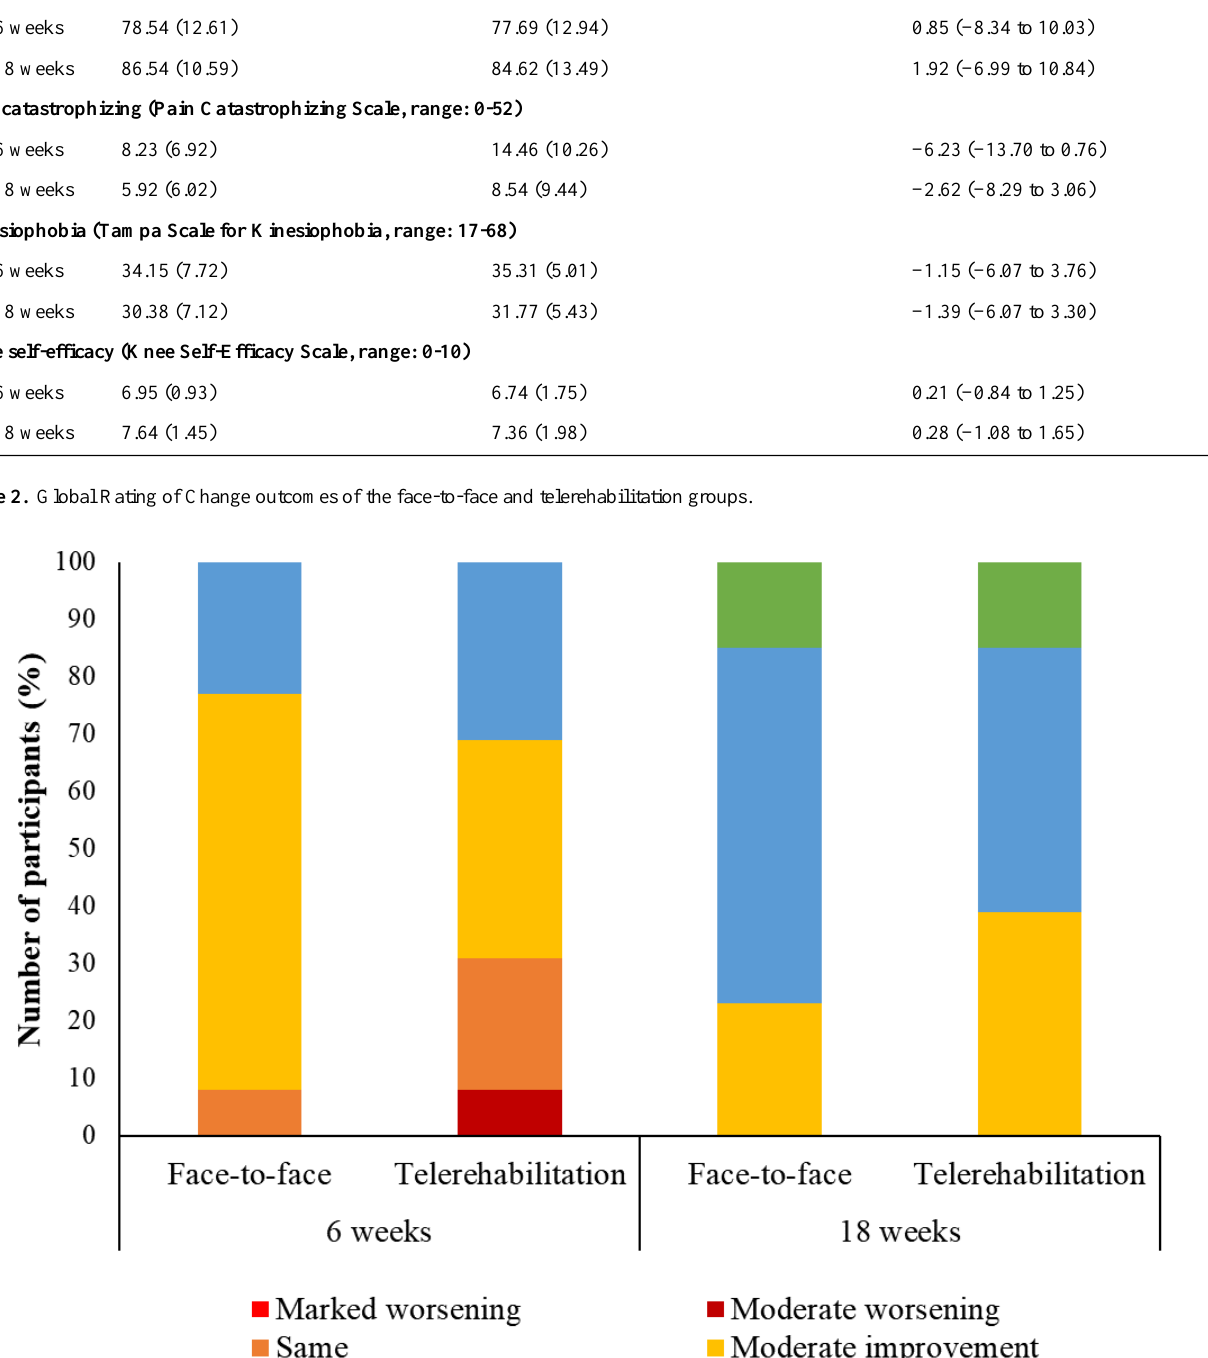
Worst knee pain (visual analog scale, range: 0-100)